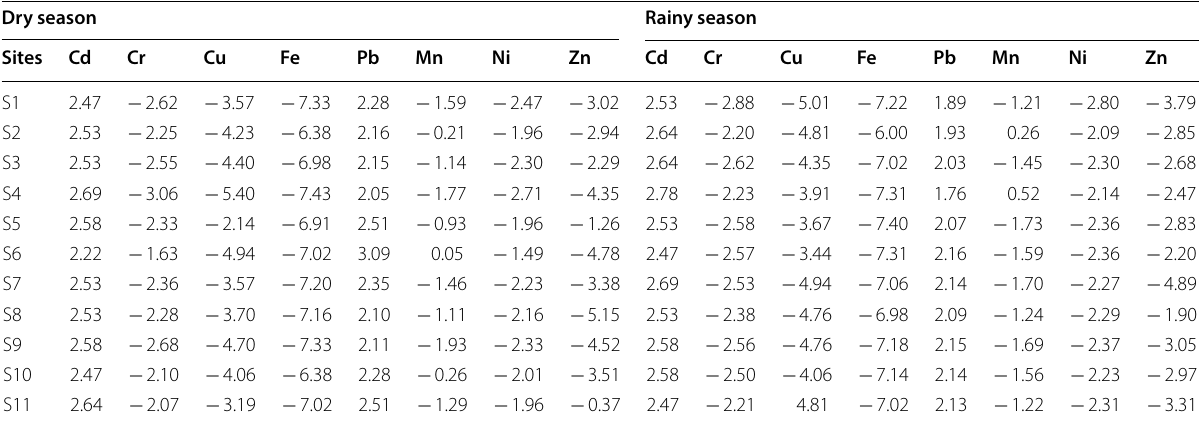
Table 7 Geoaccumulation index (Igeo) values of trace elements in the sediment Dry season